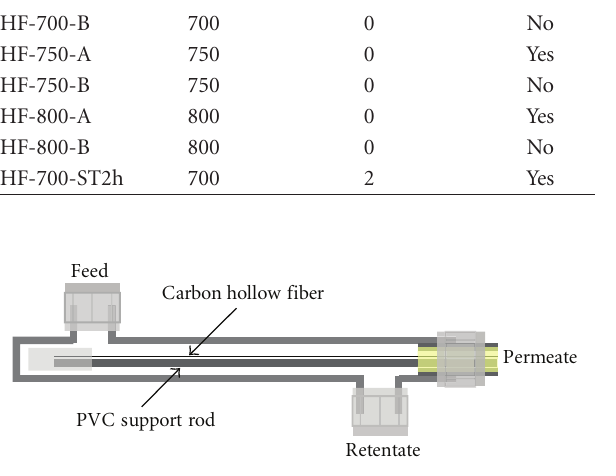
Figure 3: Scheme of the membrane